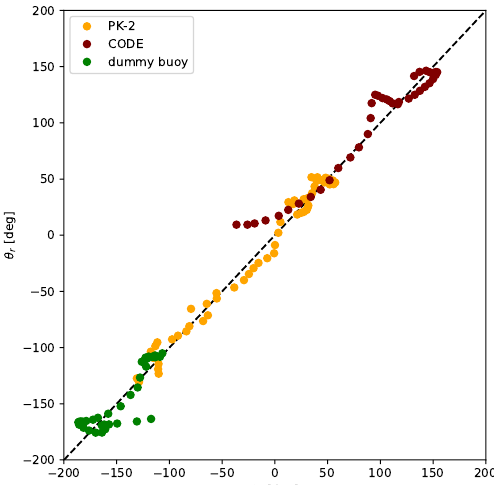
Figure 9. Scatter plot of the direction of the observed and reconstructed velocities for the three